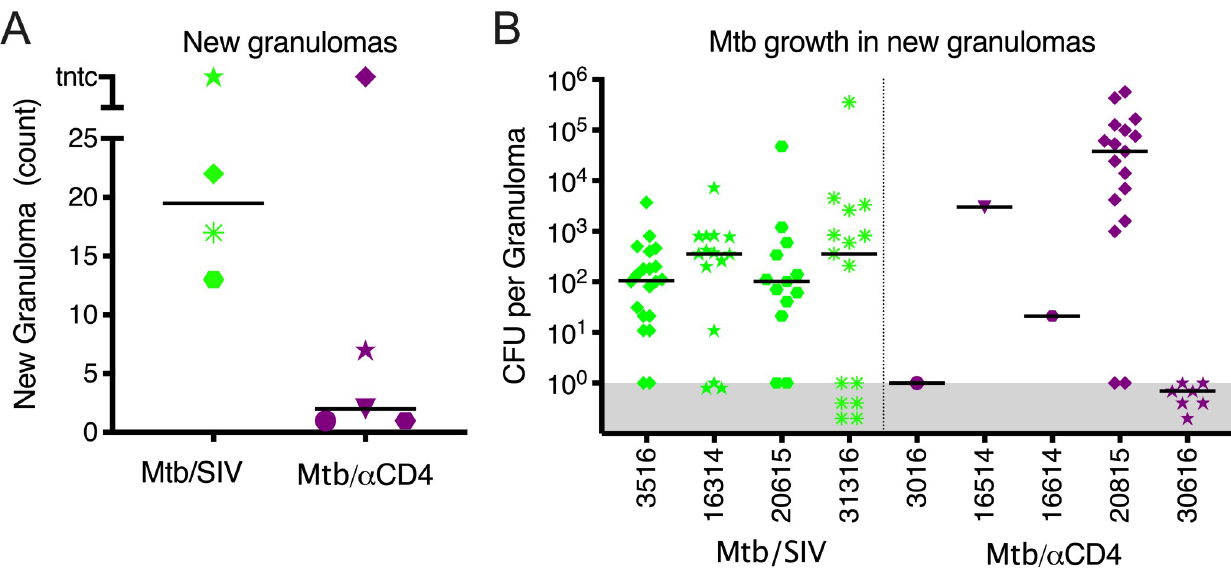
Fig 3. SIV-induced reactivation is characterized by more new granulomas that are permissive to Mtb growth compared to CD4 depletion. A) The number of newly formed granulomas identified by PET CT during subclinical reactivation, among Mtb/SIV (green, ranging from 13 to tntc) and Mtb/ α CD4 (purple, ranging from 1 to tntc) NHP. TNTC = too numerous to count and was set at 100 (Mann-Whitney, P = 0.1270). Individual monkeys are identified by different shapes. B) Mtb growth from new granulomas of Mtb/SIV and Mtb/ α CD4 NHP are shown. Points that fall within the grey bar were sterile. Numbers on x-axis represent individual monkey identification numbers. Lines represent medians. In A), each shape represents an individual animal; in B), each shape represents an individual granuloma.